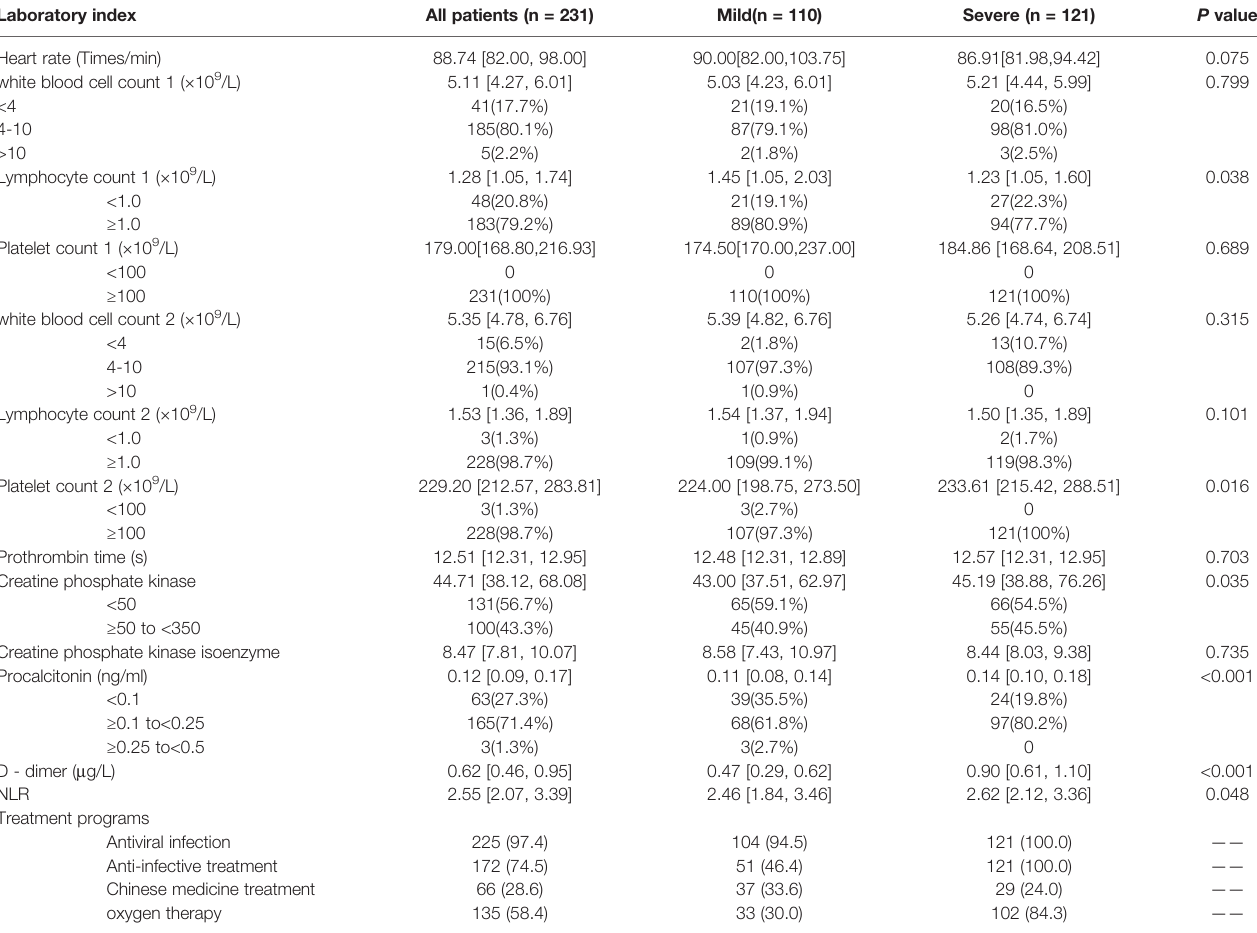
TABLE 2-2 | Laboratory test results and treatment plan of COVID-19 patients during hospitalization after SMOTE algorithm balancing data. Laboratory index All patients (n =